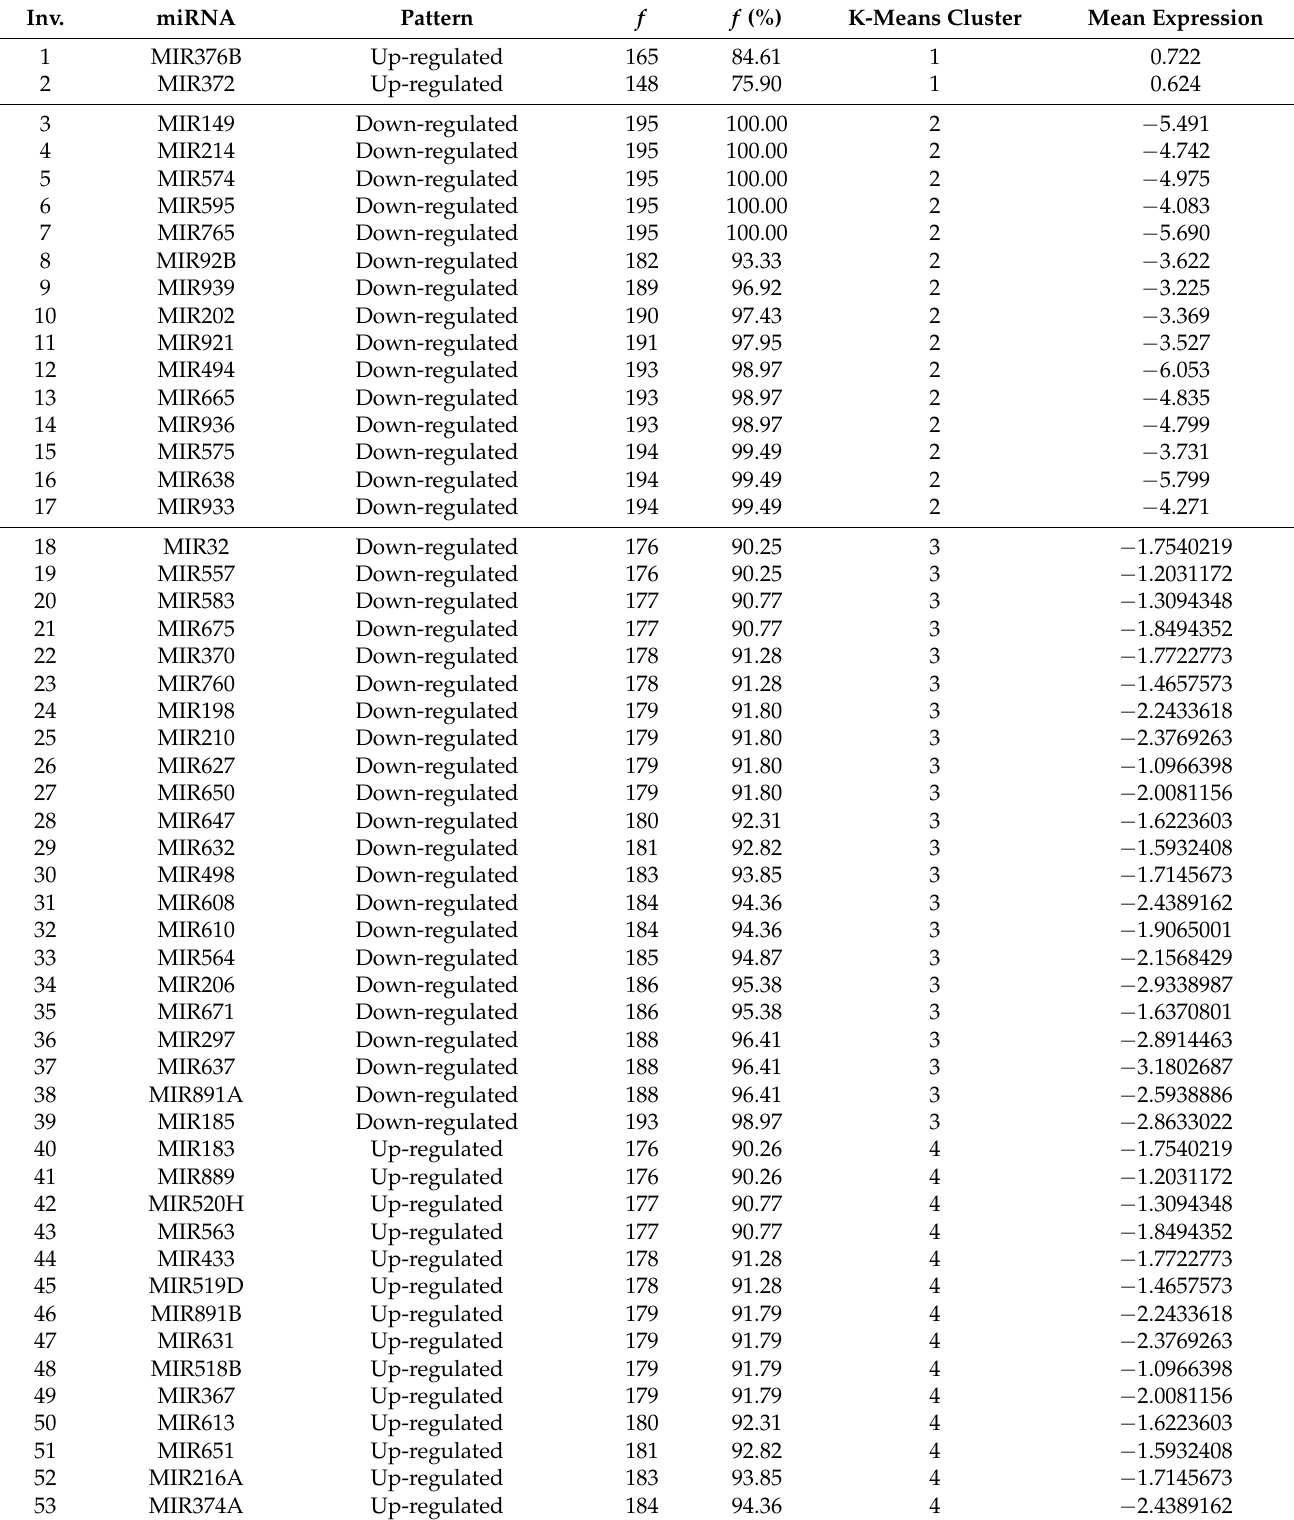
Table 3. Common up- and down-regulated miRNAs across all CNS tumors. K-means clusters were also analyzed for the presence of co-DE miRNAs in all samples. MiRNAs were considered to manifest a common pattern of expression if they were globally up-regulated in at least >75% of all samples or down-regulated in at least >90% of all samples. All miRNAs were sorted with respect to their cluster